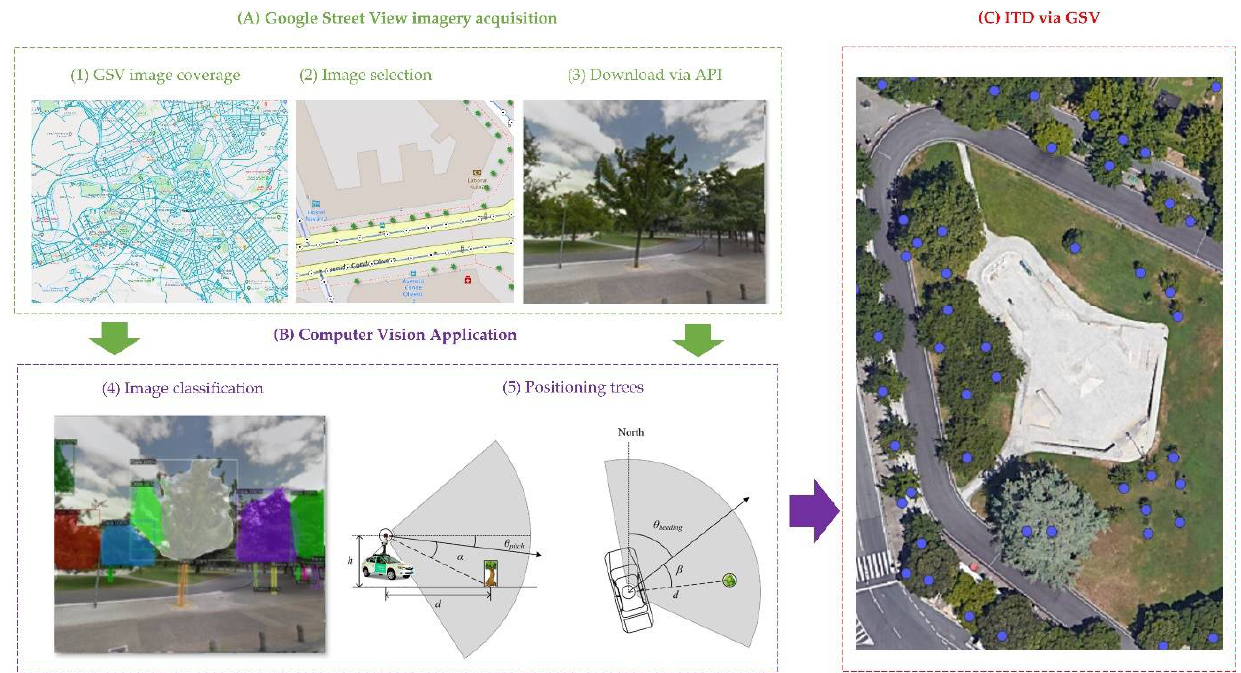
Figure 4. Graphical summary of stage 1A to perform individual tree detection based on the use of computer vision on Google Street View images.